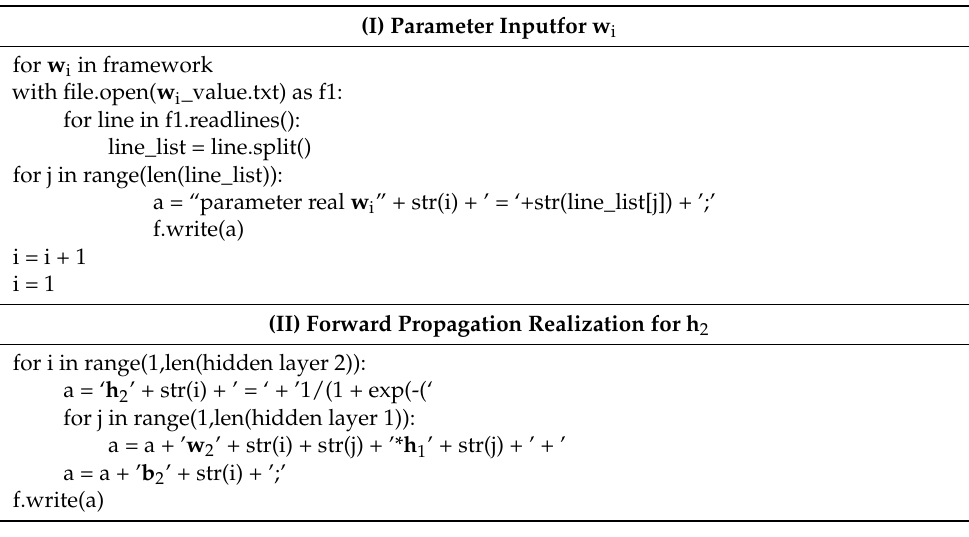
Table 2. The pseudo code for transforming the ANN to Verilog-A language. (I) Parameter Inputfor w